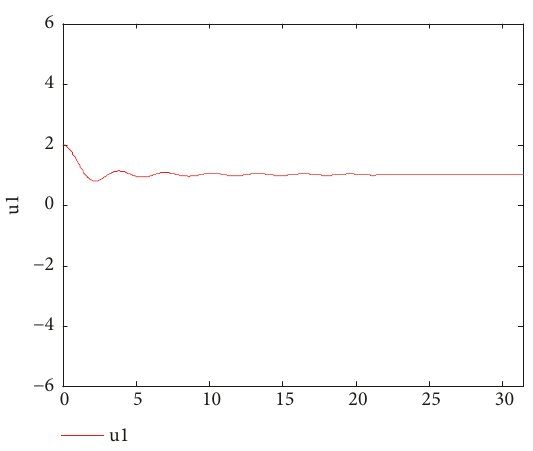
Figure 1: The velocity input 𝑢 1 for the kinematics